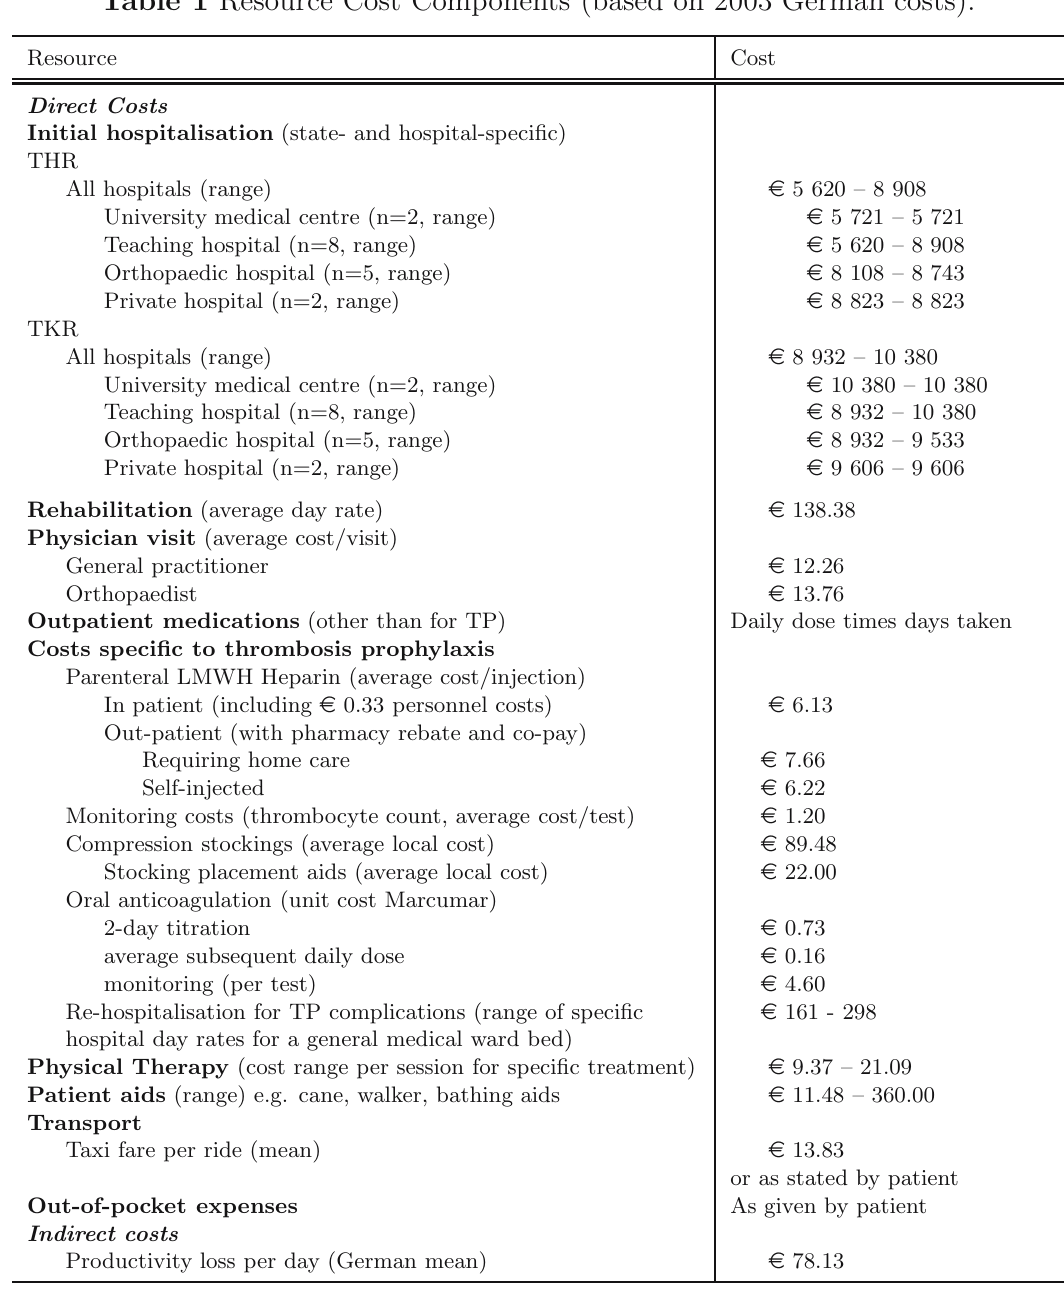
Table 1 Resource Cost Components (based on 2003 German